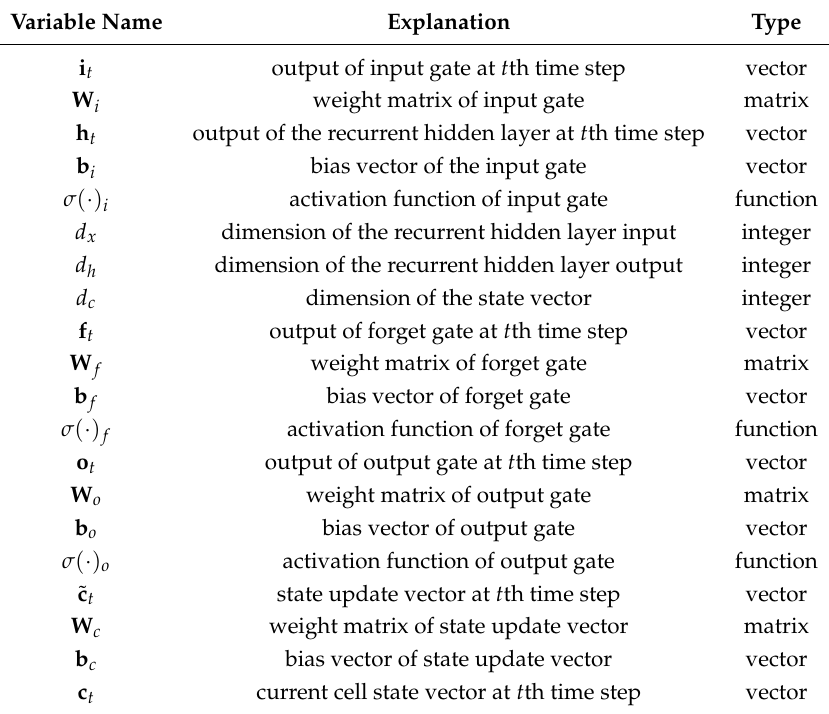
Table 1. Illustration of parameters in the LSTM network